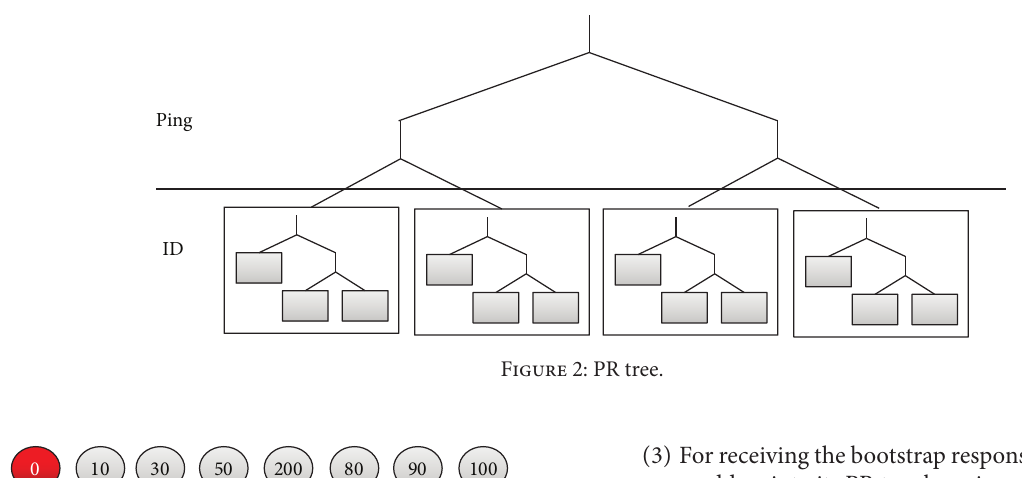
Figure 3: Example of eight nodes with their RTT